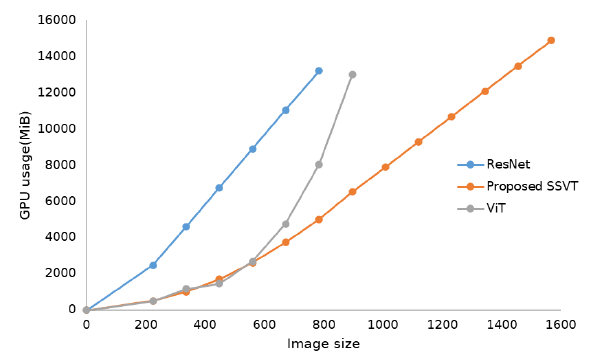
Figure 13. Inference GPU memory usage of ResNet, original ViT, and proposed